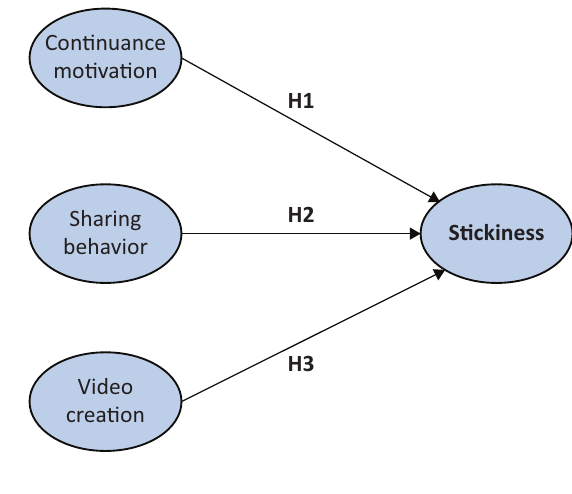
Figure 1. Proposed